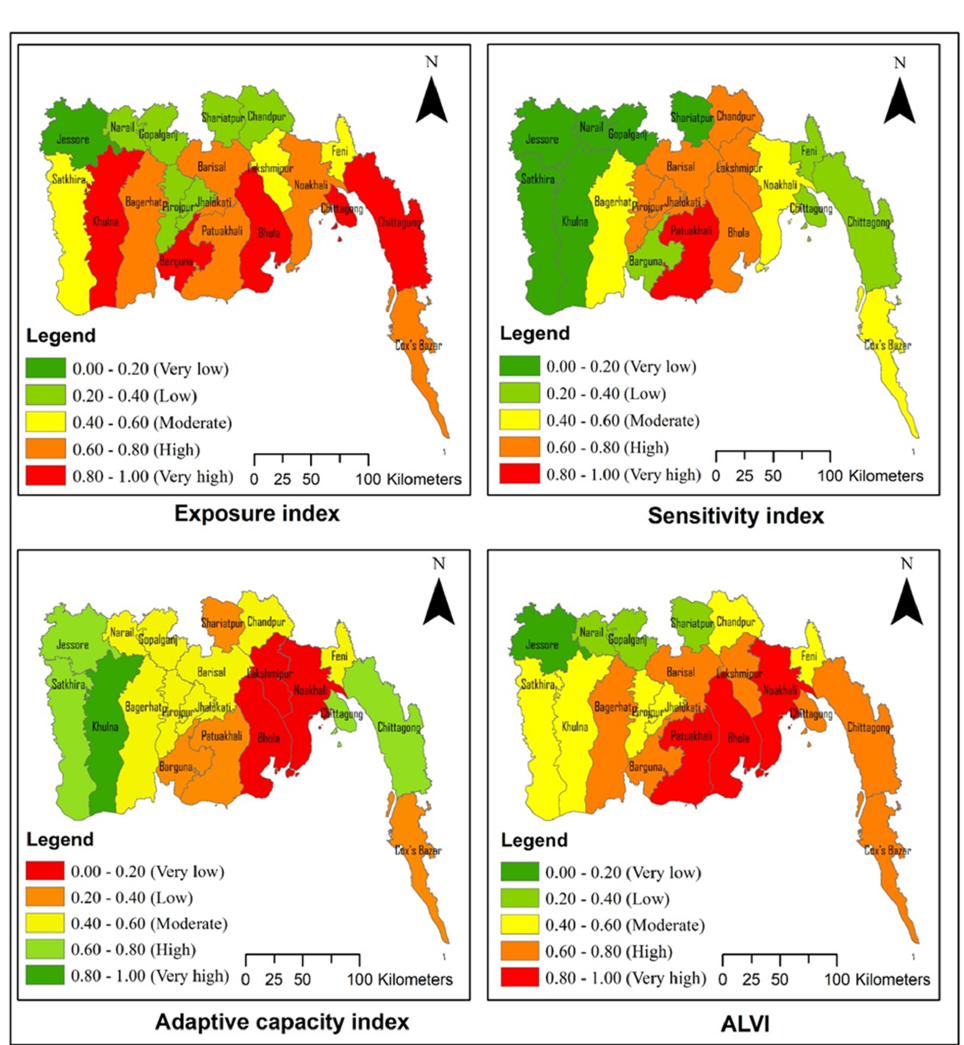
Figure 3. Mapping of spatial variation of exposure index, sensitivity index, adaptive capacity index, and agricultural livelihood vulnerability index, across the coastal districts.